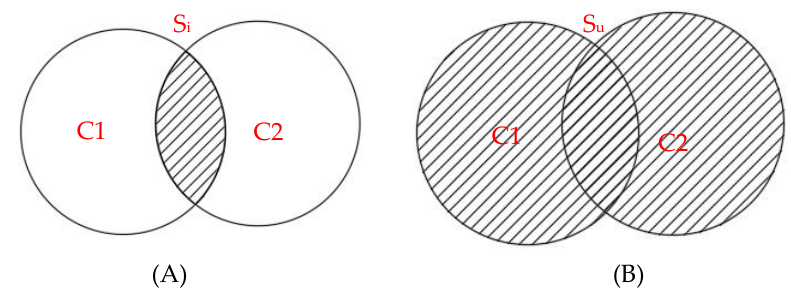
Figure 6. The concept of the intersection over union ratio. ( A ) The intersection; ( B ) the union.